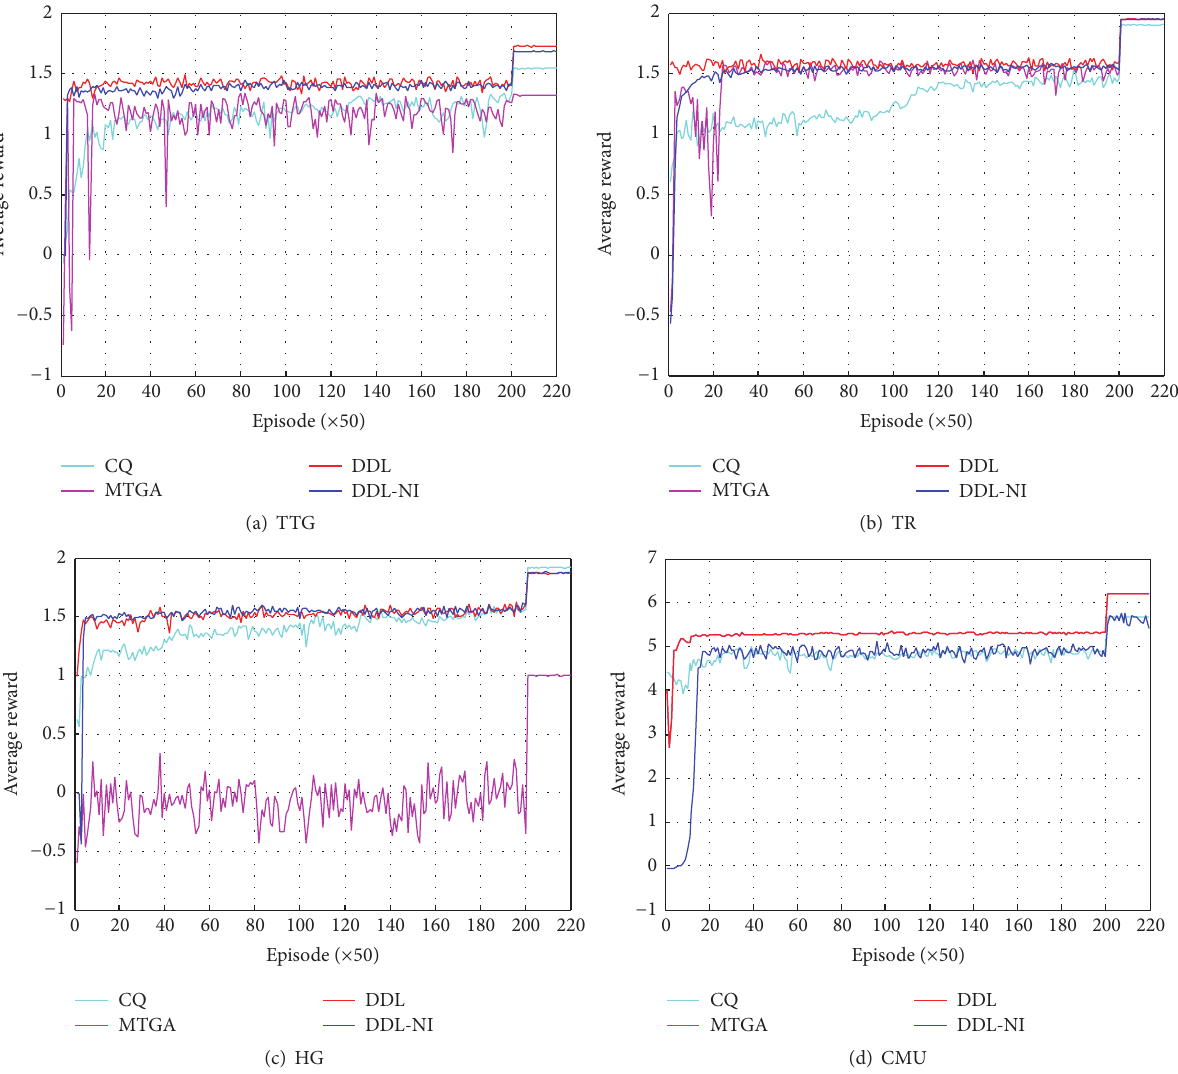
Figure 5: The learning curves of the tested approaches in games TTG, TR, HG, and CMU when interactions between agents are unilateral.